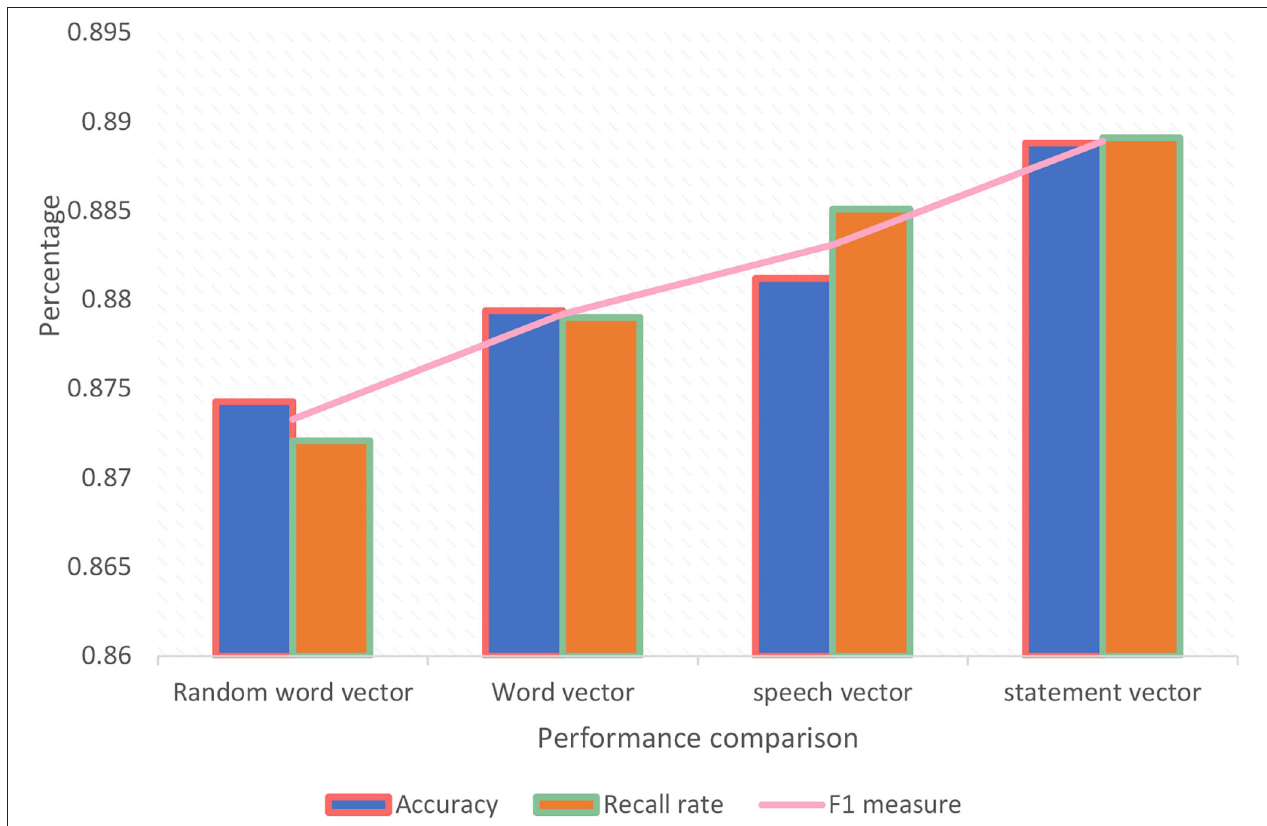
FIGURE 6 | Performance comparison between